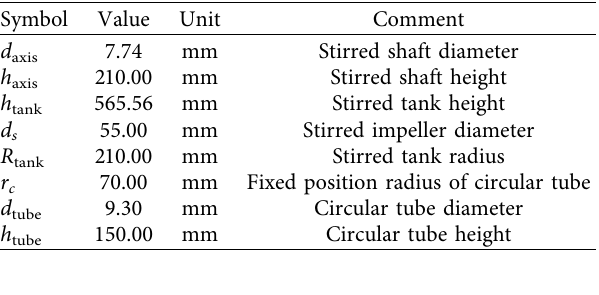
Figure 2: Computational domain and mesh grid. (a) Traditional chromite leaching stirred reactor. (b) Dynamic-static combined chromite leaching stirred Table 1: Geometric dimensions of tank.